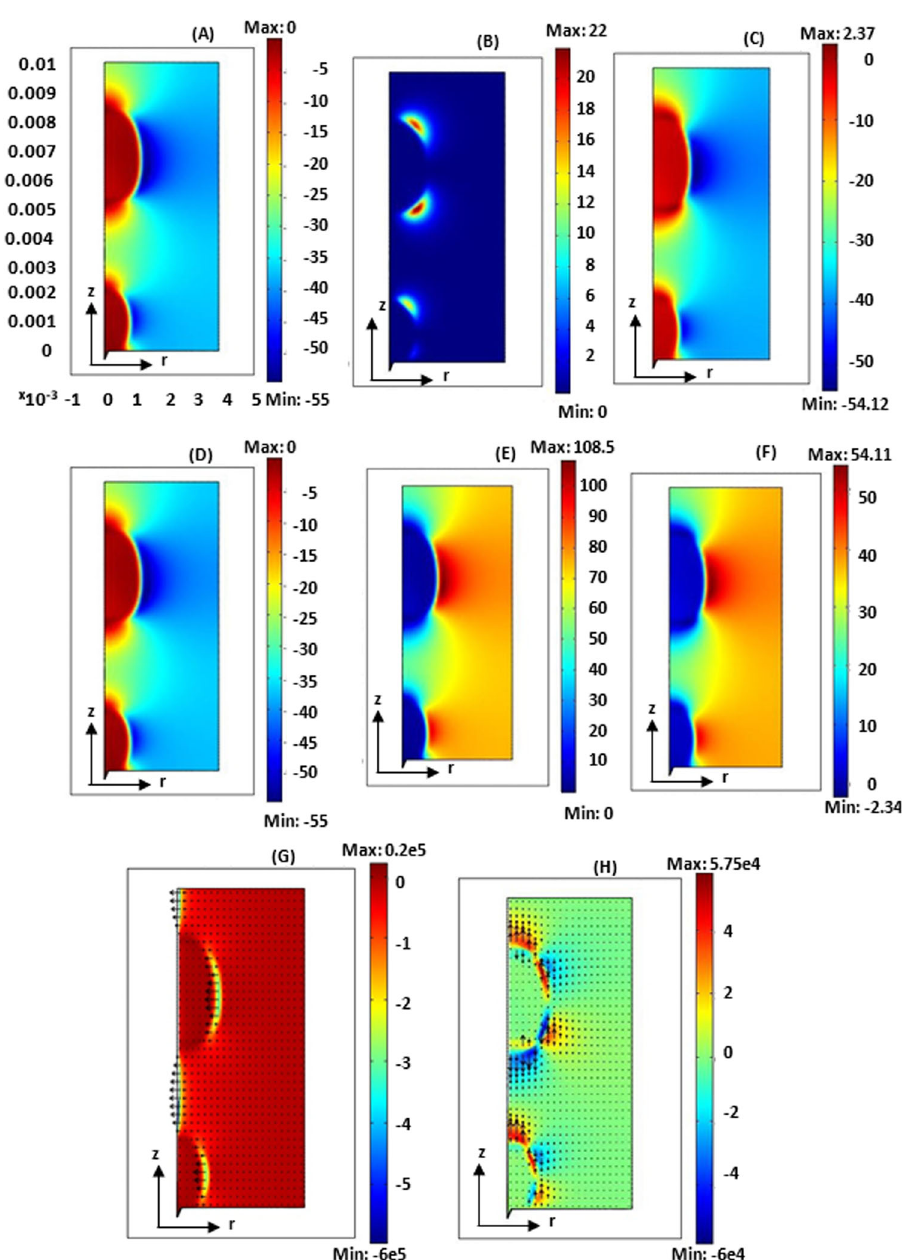
Fig. 3 Radial and vertical component of the maxwell tension tensor for superheat 8.5 °C and the contact angle 50° at a voltage of 4000 V. A – C The radial component of the maxwell tension tensor ( A ) the fi rst term of the radial component of the Maxwell stress tensor ( B ) the second term of the radial component of the maxwell tensile tensor ( C ) the radial component of the Maxwell stress tensor. ( D – F ) the vertical component of the maxwell tension ( D ) the fi rst term of the vertical component of the Maxwell stress tensor ( E ) the second term of the vertical component of the maxwell tensile tensor ( F ) the vertical component of the Maxwell stress tensor. ( G , H ) electrohydrodynamic force applied to the growing bubble ( G ) radial force ( H ) vertical force. For all ( A to H ), the x-axis is the bubble diameter and y-axis is the bubble height and the unit of the x-axis and y-axis is meter. The unit of rainbow colorbars is N (newton). Arrows in G and H are radial and vertical EHD forces